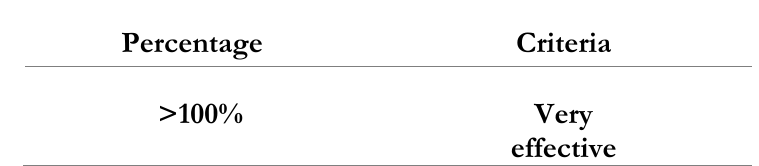
Table I Interpretation of Effectiveness